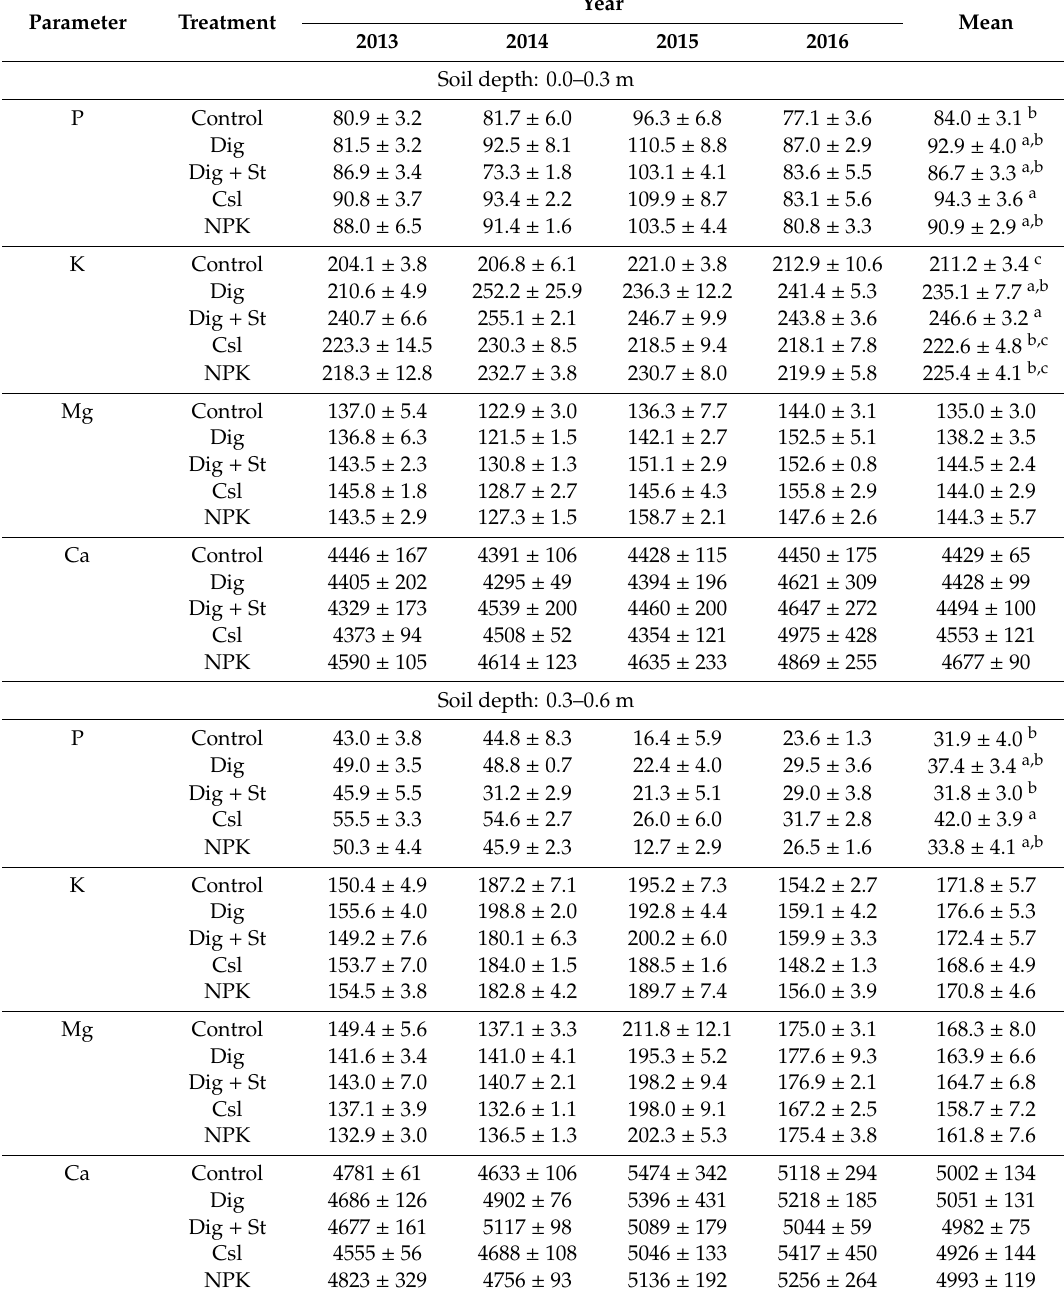
Table 5. Plant-available P, K, Mg, and Ca in soil samples (mg kg − 1 ) determined by Mehlich 3 method as a result of application of digestate (Dig), digestate + straw (Dig + St), cattle slurry (Csl), and mineral fertilizers